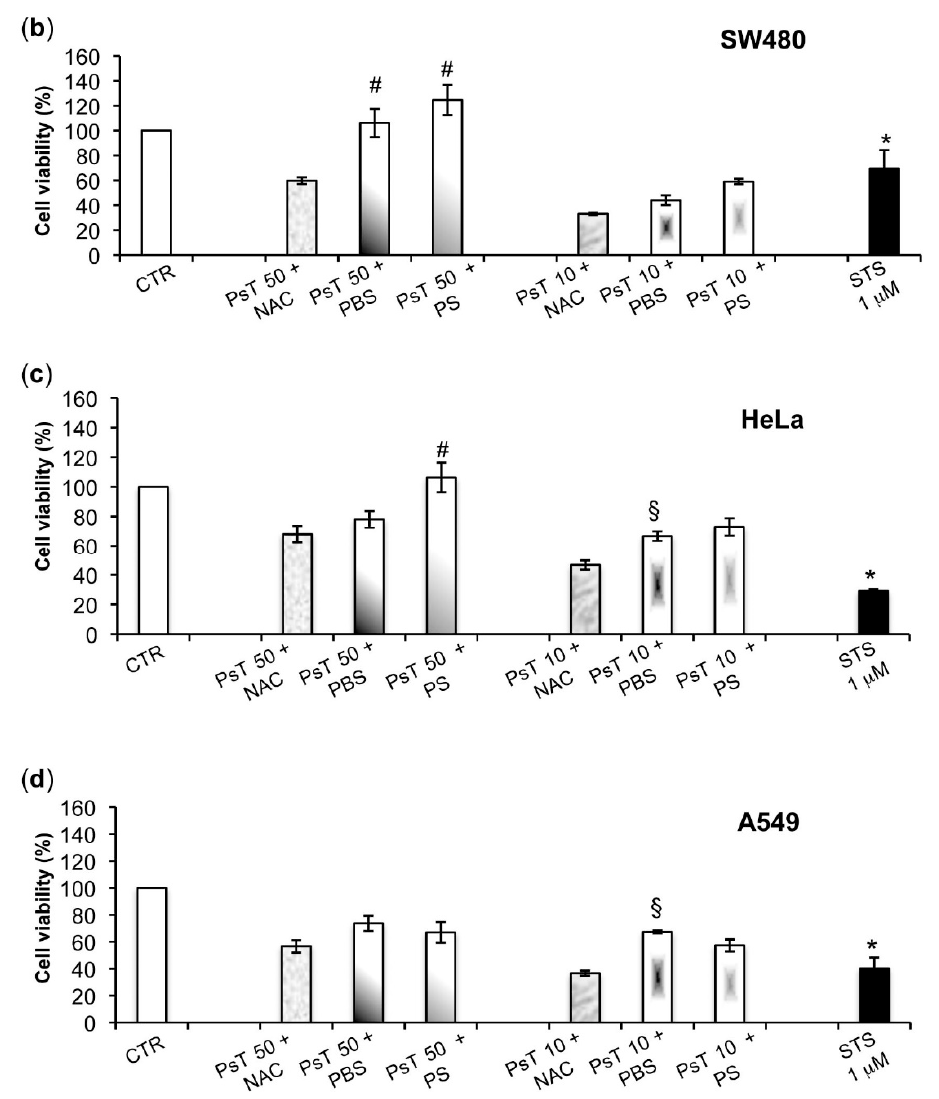
Figure 2. Cytotoxic effect determination of PsT 50 mg/mL and PsT 10 mg/mL diluted with NAC, phosphate buffer saline (PBS) or physiological solution (PS) vehicles. HCT116. ( a ) SW480 ( b ) HeLa ( c ) A549 ( d ) cells were treated for 24 h and cell viability was evaluated using an MTT test. Staurosporine (STS, 1 µ M) was used as positive control. Results showed that PsT in association with NAC was effective in all examined cell lines. Cell viability was assessed by MTT assay, performed for six independent experiments. One-way ANOVA was applied. # = significant difference compared to cells treated with (PsT 50 mg/mL + NAC) ® , p < 0.05; § = significant difference compared to cells treated with (PsT 10 mg/mL + NAC) ® , p < 0.05; * = significant differences compared to control cells ( p < 0.05).